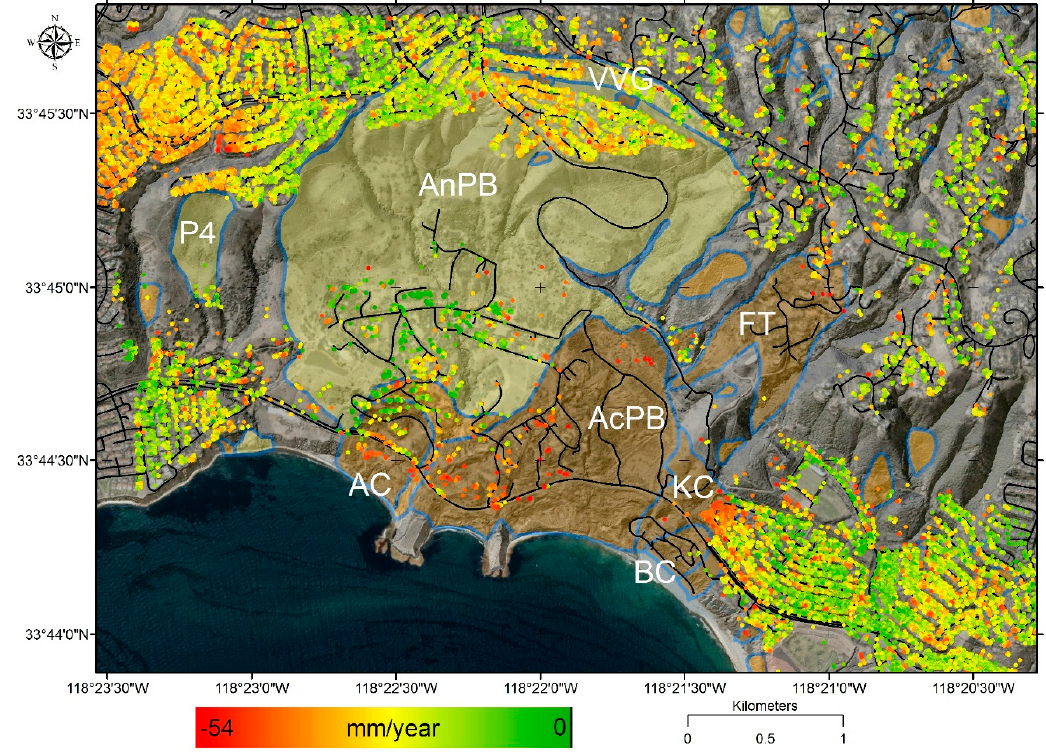
Figure 7. Average velocity (mm / year) between 19 July 2012 and 27 September 2014 measured using 40 COSMO-SkyMed images with PSI processing. Negative velocity values measure deformation away from the satellite.